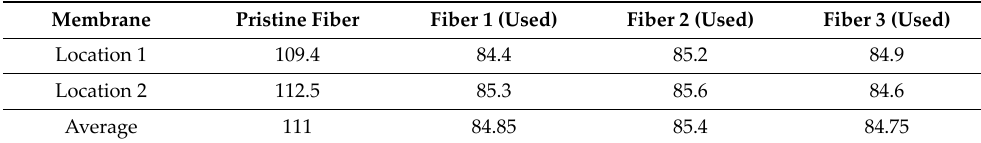
Table 5. Contact angle results of membranes used in Experiment